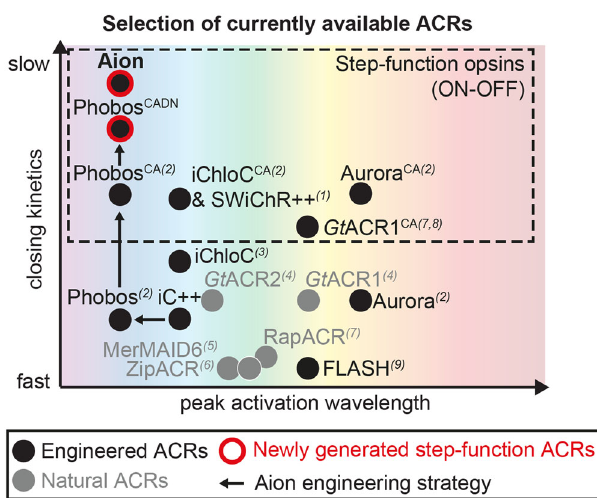
Fig. 7 Aion broadens the available toolkit of optogenetic silencers in the temporal domain. Schematic diagram showing a selection of the currently available ACRs used as optogenetic silencers in neurons. The ACRs are sorted according to their approximate peak activation wavelength ( x -axis) and closing kinetics ( y -axis). Engineered and natural ACRs are depicted as black and gray circles, respectively. Phobos CADN and Aion, the slow-cycling ACRs developed in this study, are highlighted with a red outline and the engineering strategy is indicated by black arrows. References to the published ACRs are indicated by numerical superscripts: 1 9 , 2 11 , 3 10 , 4 13